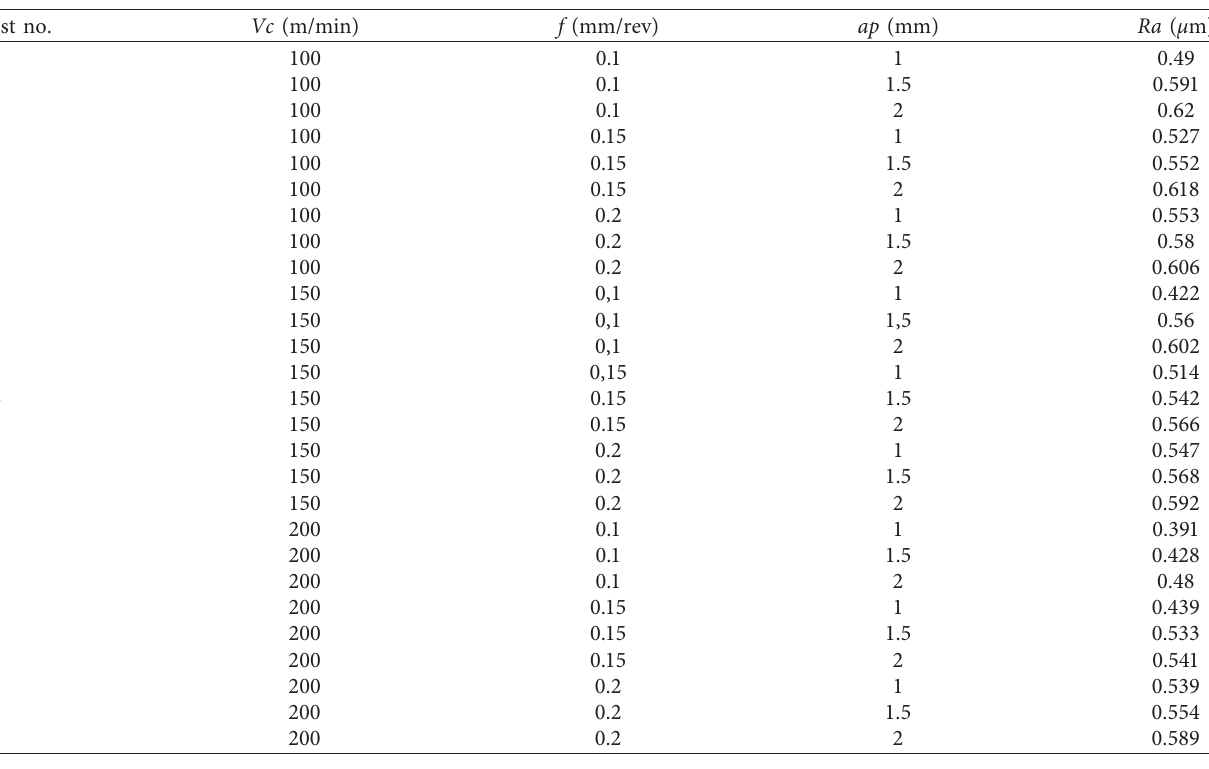
Table 2: Experimental data for AA6061 aluminium